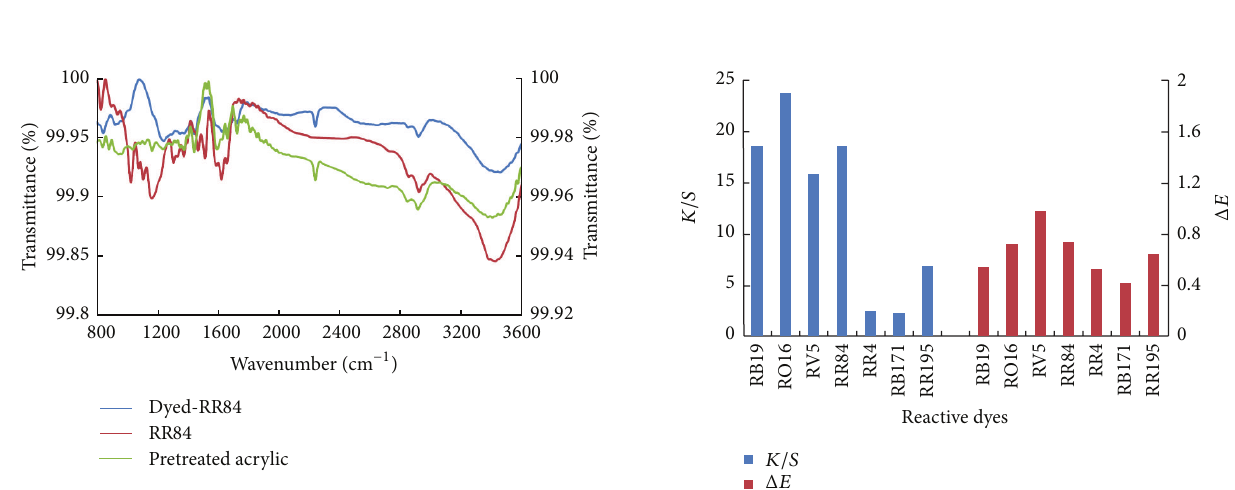
∗ St. = staining on cotton. ∗∗ St. = staining on wool. ∗∗∗ St. = staining on acrylic. Alt. = alteration. a